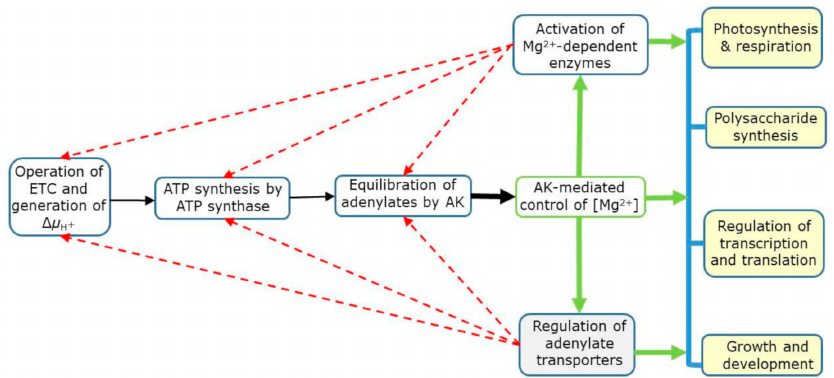
Figure 5. A simplified view of the Mg 2+ role as enzyme substrate/cofactor and as a signal arising from adenylate pools. Abbreviations: AK, adenylate kinase; ∆ µ H +, membrane electrochemical potential; ETC, electron transport chain. Red dotted arrows refer to feedback control by Mg 2+